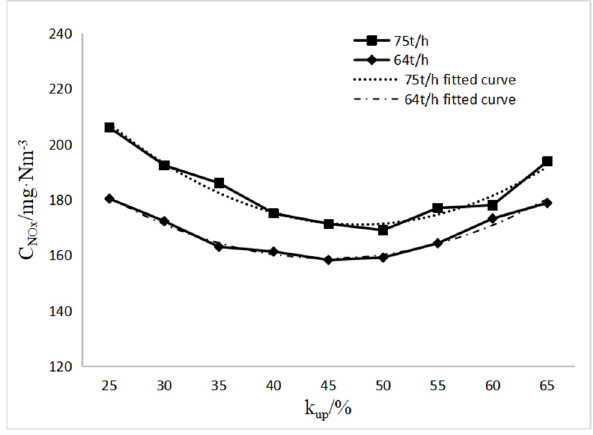
Figure 4. Effect of k up on C NOx .